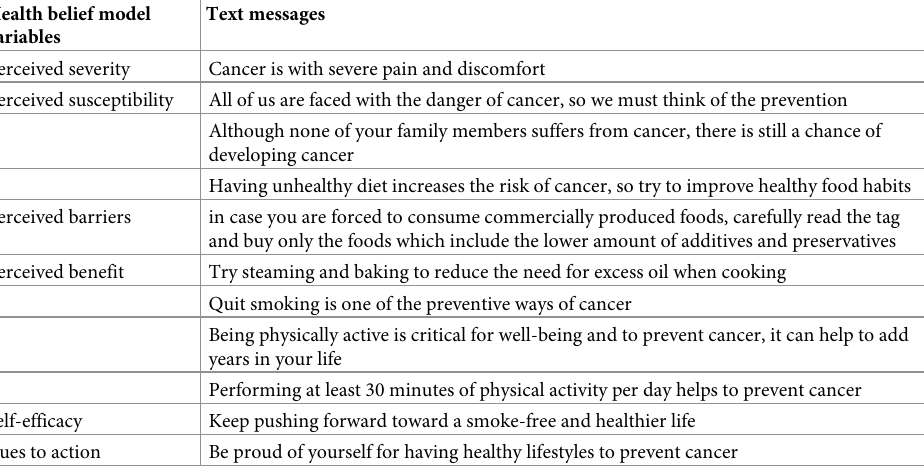
Table 1. Sample of text messages with each health belief model variables for evaluating text message intervention on the behavioral risks of cancer, Ethiopia,